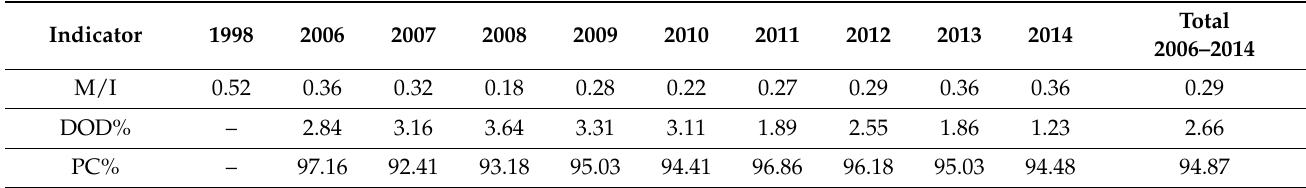
Table 5. Quality control of data on cervical cancer cases registered at the Territorial Cancer Registry of the North-Western Region of Romania, period